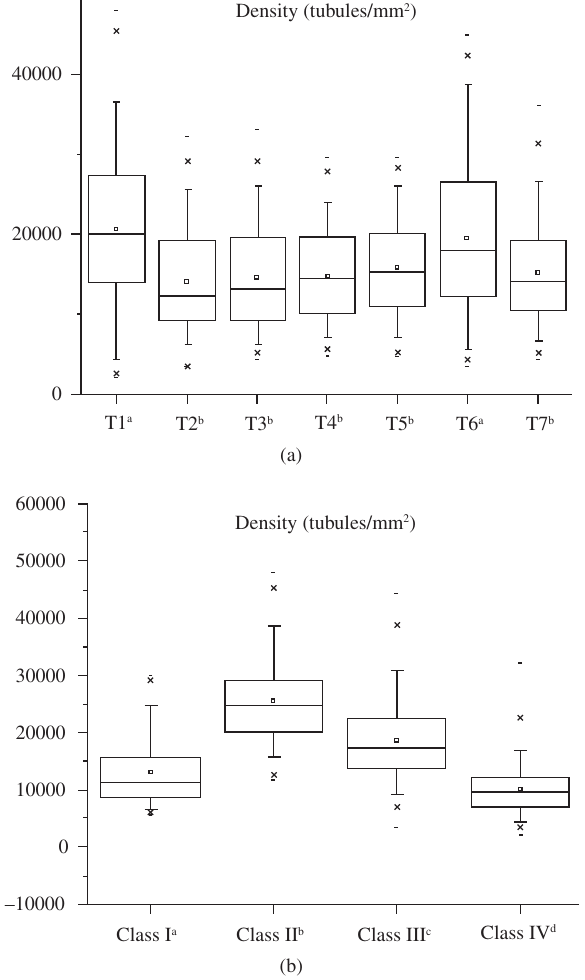
Figure 3. Variation of the density of tubules (a) per tooth and (b) per class of dentin.